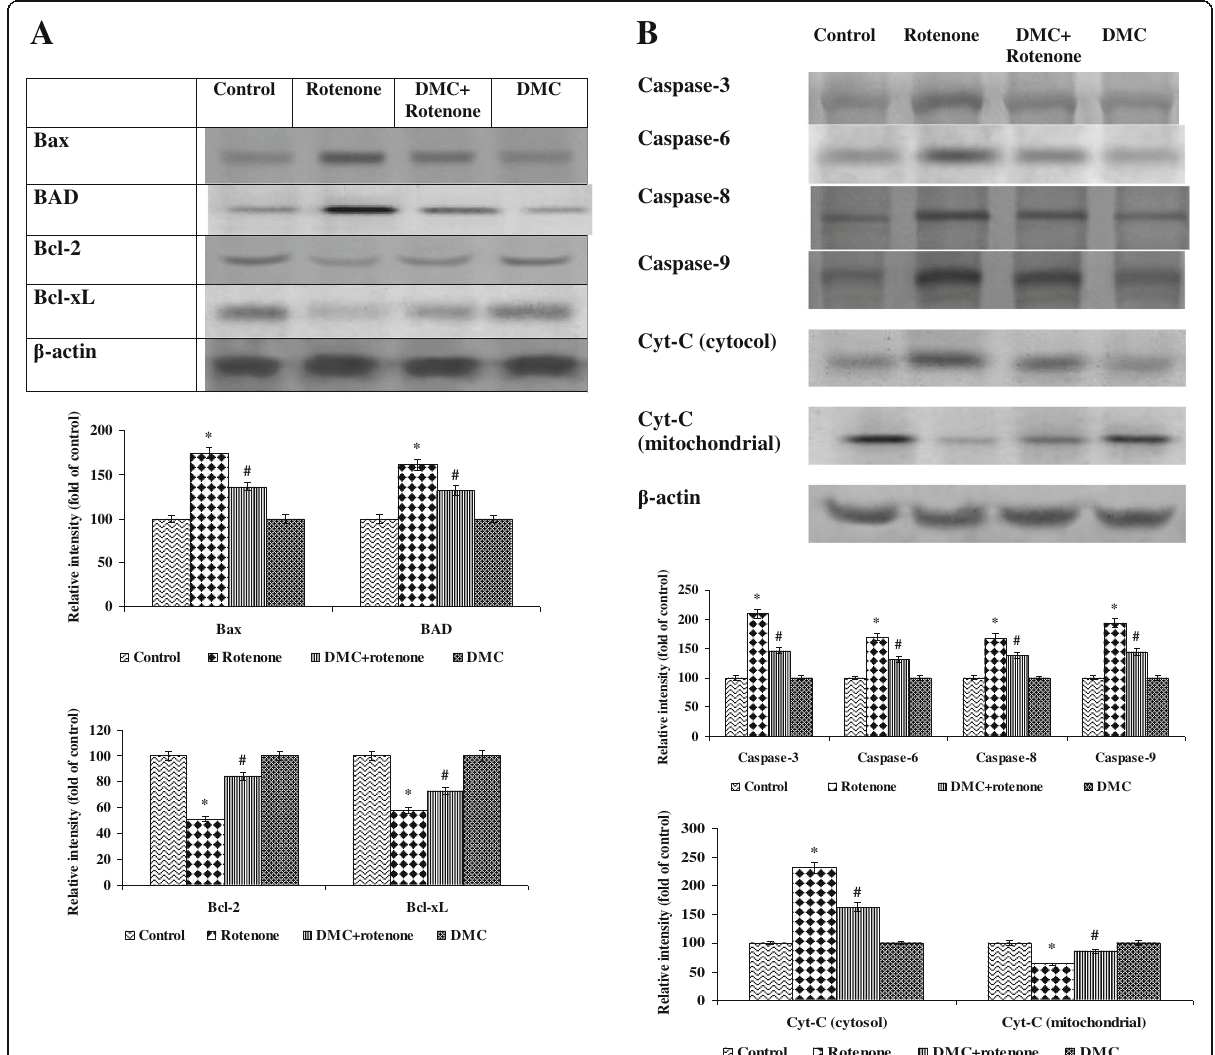
Fig. 8 The effect of DMC on the expressions of apoptotic proteins. a and b show the expression of Bax, BAD, caspase-3, caspase-6, caspase-8, caspase-9 in mitochondria and Cyt-c in cytosol was increased while the expressions of Bcl-2, Bcl-xL and Cyt-c in mitochondria was significantly decreased by the rotenone treatment as compared with control. Pretreatment with DMC gradually restored the imbalanced expression profile of these proteins. Immunoblots are representative of at least four independent experiments. Values are given as mean±SEM in each group. * p <0.05 compared to control and # p <0.05 compared to rotenone group